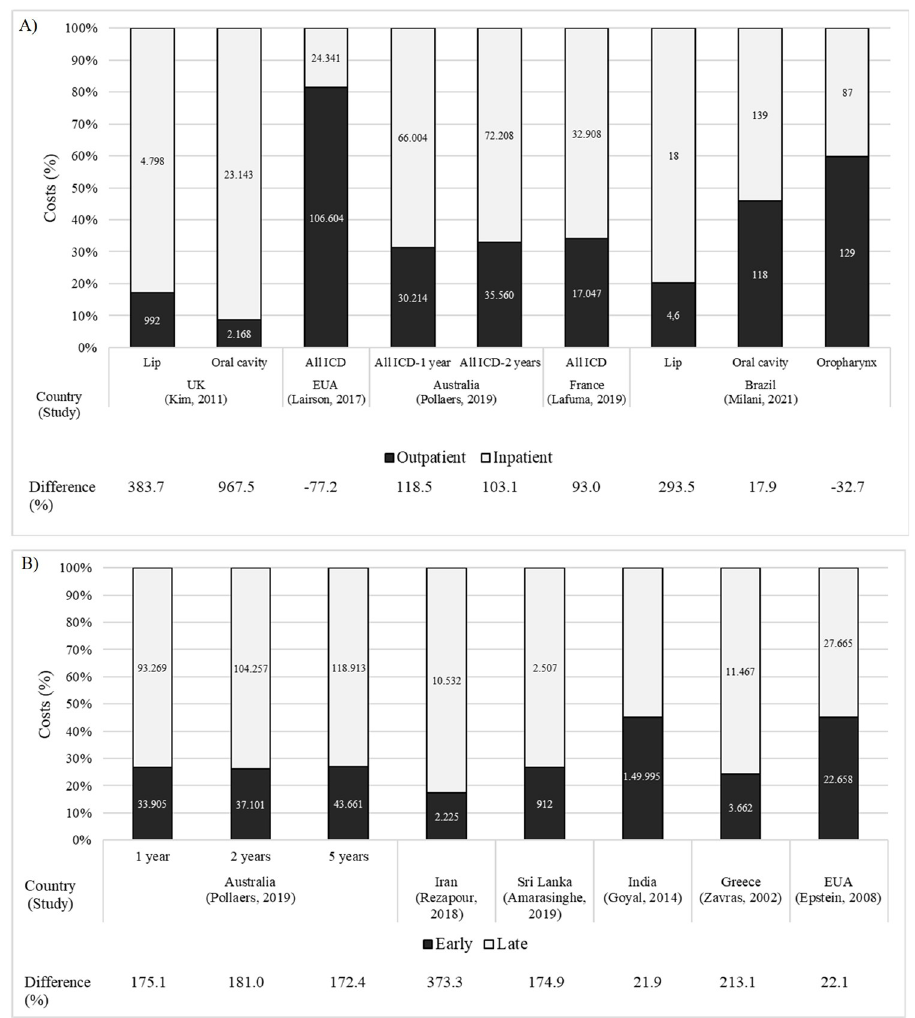
Fig 2. Oral cancer burden of cost and difference of costs (%) according to types of patient care (A) and clinical stage of the disease (B). Difference (%) = [(inpatient cost–outpatient cost)/outpatient cost x 100]. Currency: Kim,2011: